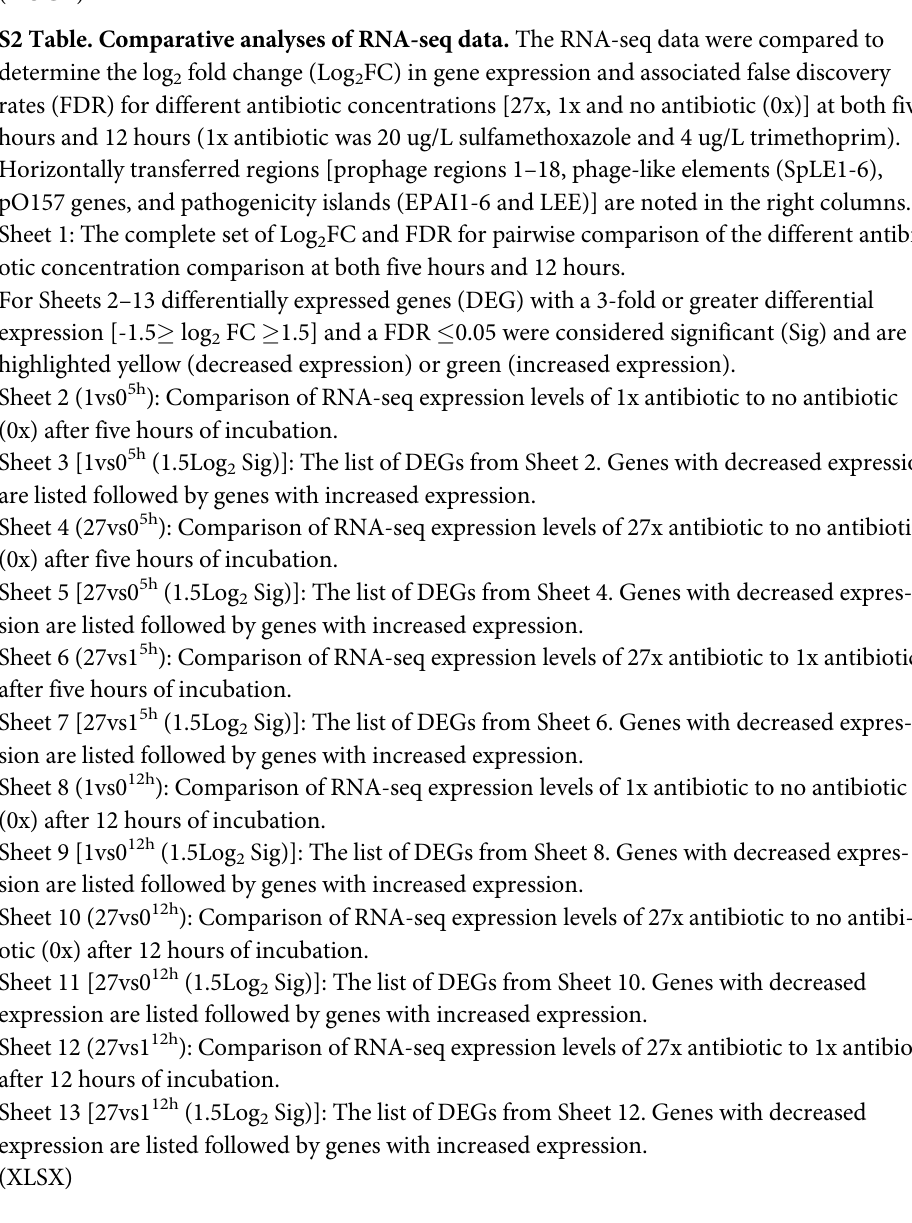
S2 Table. Comparative analyses of RNA-seq data. The RNA-seq data were compared to determine the log fold change (Log FC) in gene expression and associated false discovery 2 2 rates (FDR) for different antibiotic concentrations [27x, 1x and no antibiotic (0x)] at both five hours and 12 hours (1x antibiotic was 20 ug/L sulfamethoxazole and 4 ug/L trimethoprim). Horizontally transferred regions [prophage regions 1–18, phage-like elements (SpLE1-6), pO157 genes, and pathogenicity islands (EPAI1-6 and LEE)] are noted in the right columns. Sheet 1: The complete set of Log FC and FDR for pairwise comparison of the different antibi- 2 otic concentration comparison at both five hours and 12